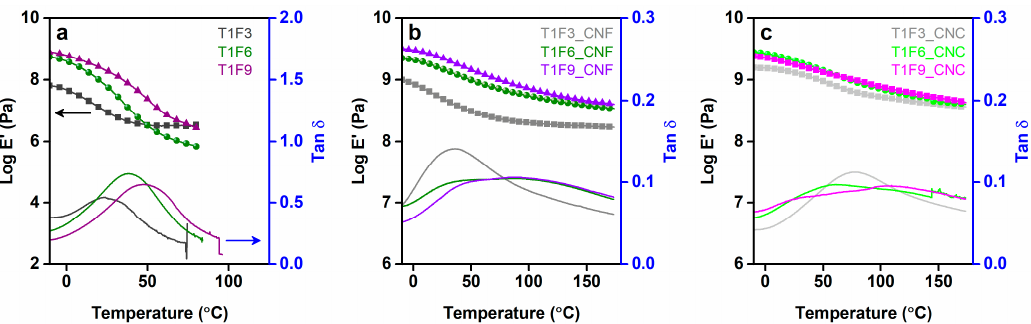
Figure 5. Storage modulus and tan δ plots from dynamic mechanical analysis. ( a ) Cured resins (T1F3, T1F6, and T1F9), ( b ) CNF-reinforced biocomposites (T1F3_CNF, T1F6_CNF, and T1F9_CNF), and ( c ) CNC-reinforced biocomposites (T1F3_CNC, T1F6_CNC, and T1F9_CNC).